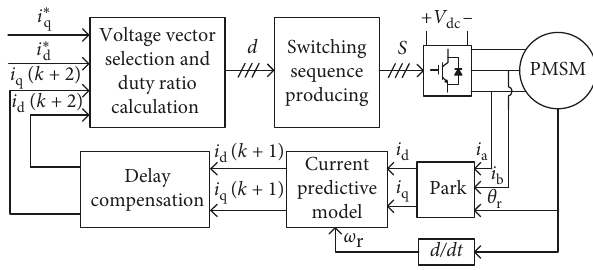
Figure 4: The control diagram of the proposed MPC-RCMV method with constant switching